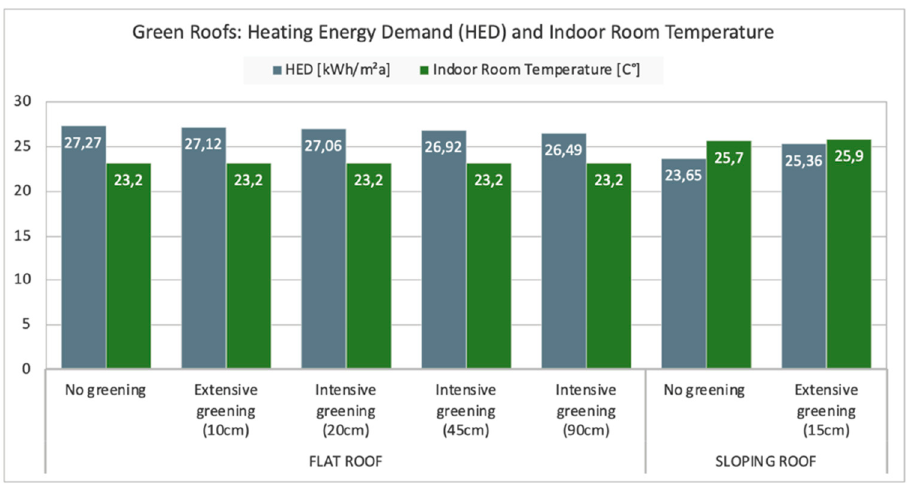
Figure 20. Heating energy demand and indoor room temperature for green roof construction types [54].